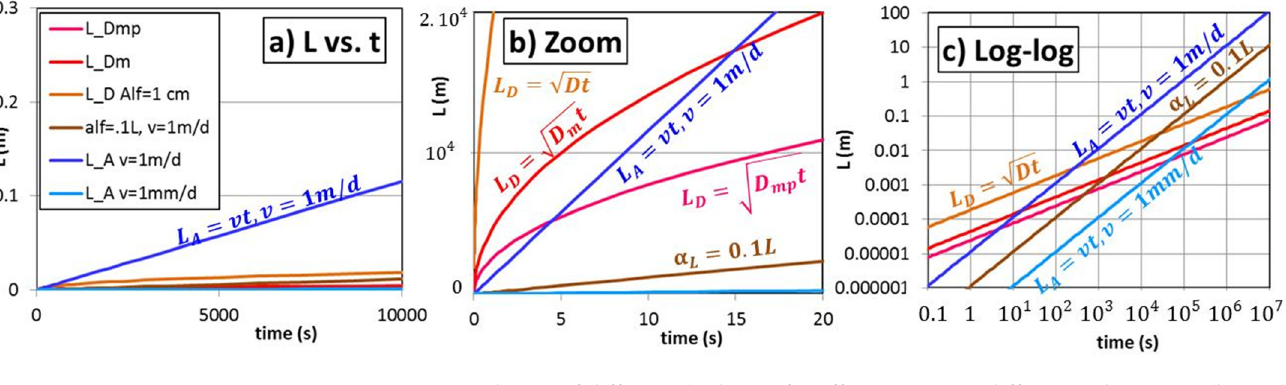
Figure 3. Time evolution of diffusion (red, D mp for effective porous diffusion), dispersion (brown) and advection (blue) lengths vs. time in arithmetic ( a ), ( b ) and log-log scales ( c ). Advection dominates sizable (meters and days) field scales (left), diffusion dominates pore scale (center). The frequent practical rule ( α L = 0.1 L, plotted here for v = 1 m/d) implies a macrodispersion that is unrealistic for mixing. Note the broad range of time and length characteristics scales that can be obtained varying α L or q